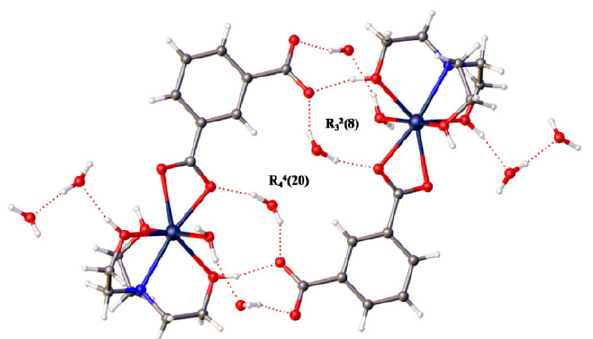
Figure 4. Packing diagram of [Cd(IsoPht)(TEA)H 2 O]·3H 2 O com- plex along the [100] direction